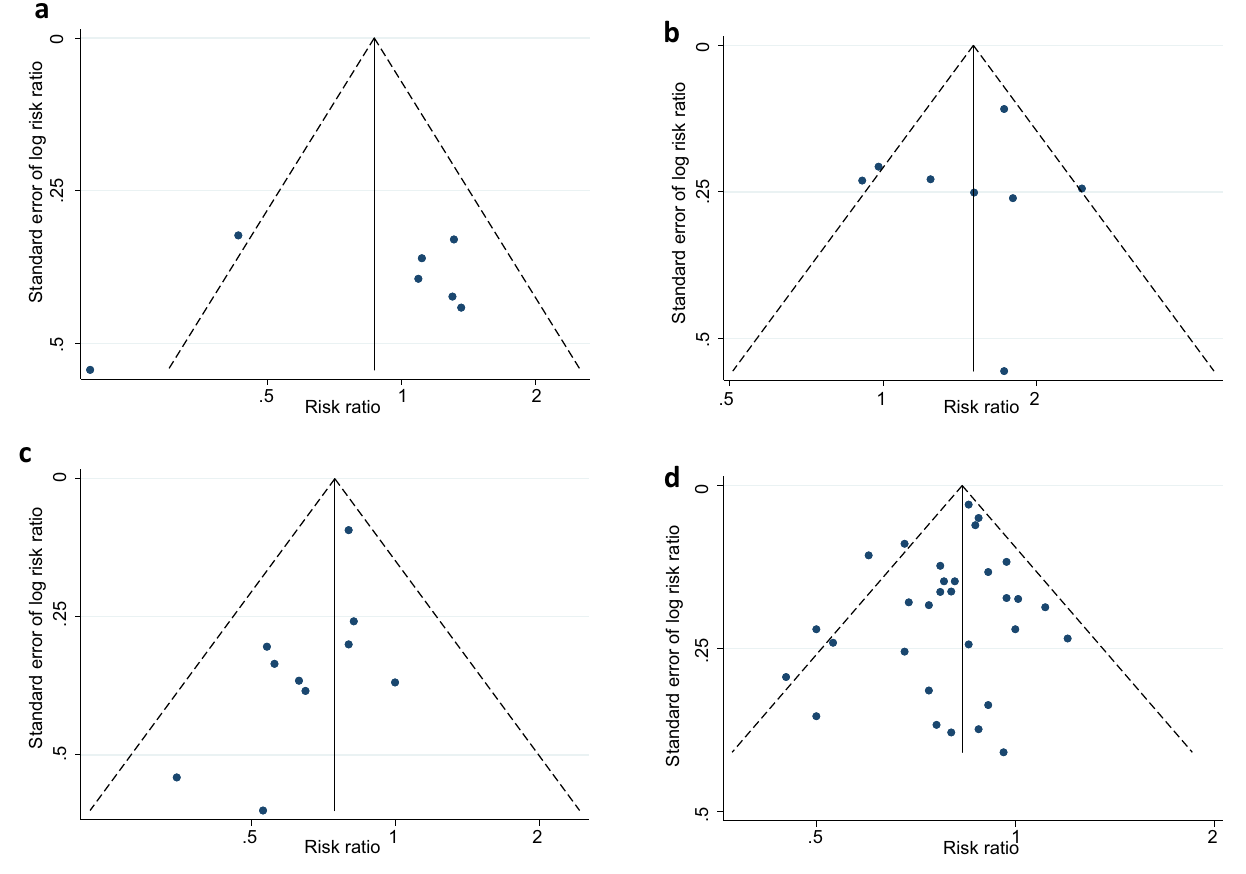
Figure 5. Funnel plots demonstrating the potential presence of publication bias in studies reporting ( a ) Neiserria Gonorrhoea, ( b ) Chlamydia Trachomatis, ( c ) Trichomonas Vaginalis and ( d ) Bacterial Vaginoses. The scatter (in each figure) represents single